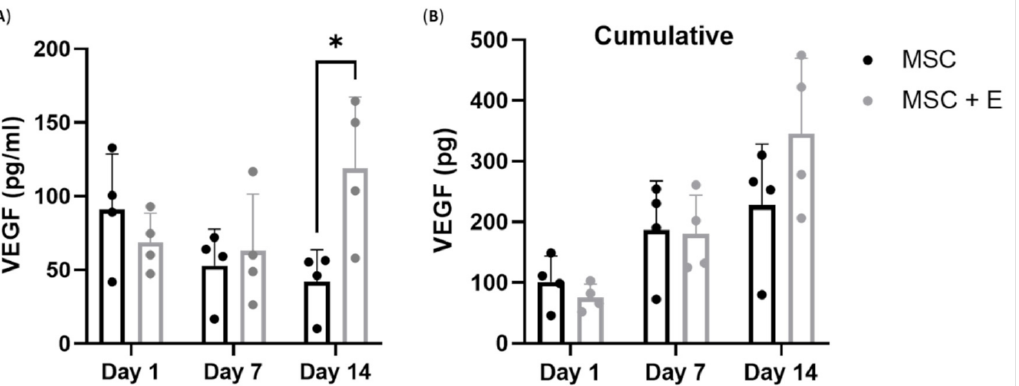
Figure 7. VEGF production by cMSCs cultured on B-HA. ( A ) VEGF concentrations in supernatants collected from cMSCs in comparison with cMSCs co-cultured with endothelial cells (+E) in B-HA and ( B ) cumulative VEGF release with time in culture. Results are shown as mean with standard error of mean for n = 4 cMSCs. * p <